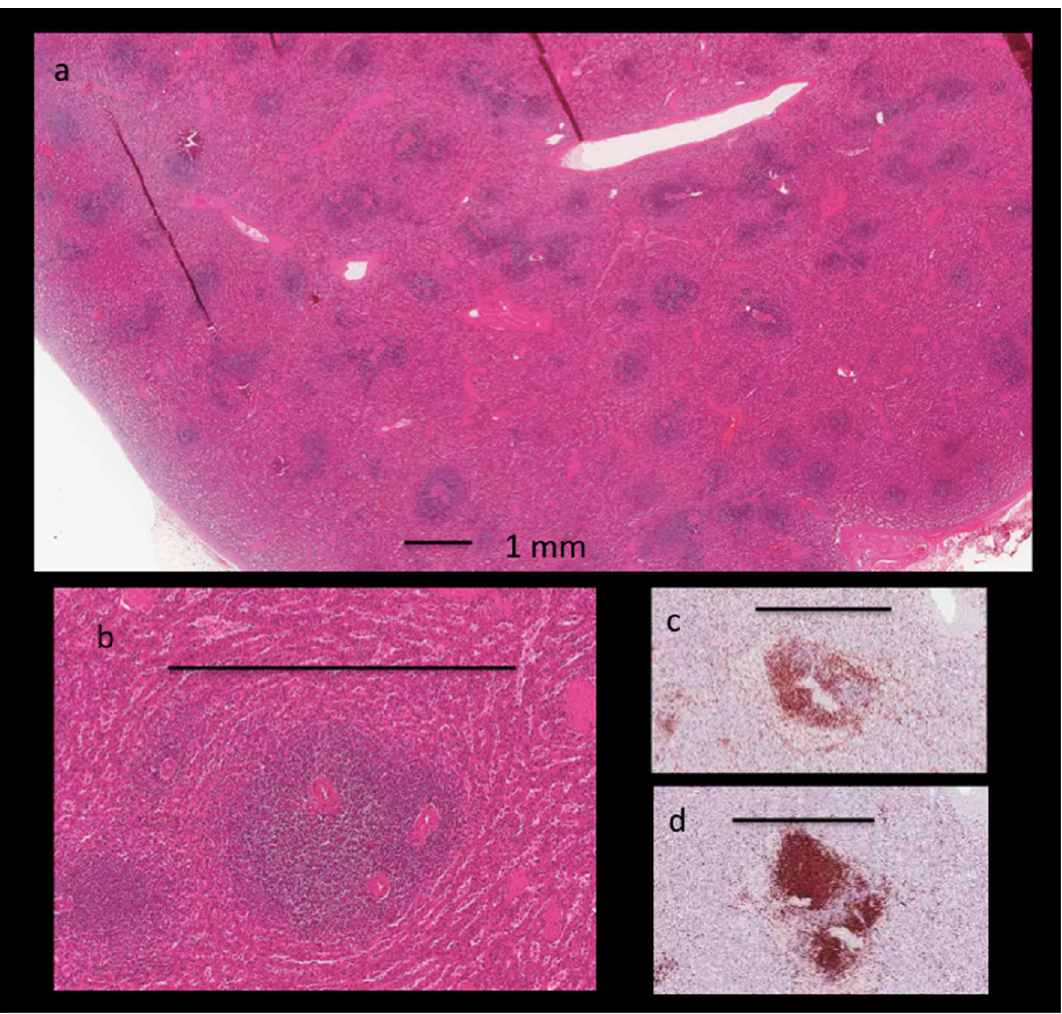
Fig. 3 Microscopic anatomy of the spleen (unrelated patient without infection, splenectomy due to injury) a Disseminated darker lymphatic follicle and periarterial lymphatic sheaths (PALS) ( ”white pulp”) are embedded in the surrounding erythrocyte rich “red pulp” (H&E stain). b Enlarged area = of PALS (H&E stain). c B-cells (CD20 ) located more peripheral and d) T-cells (CD3 ) closer to the arteriole in the PALS. All size bars + +